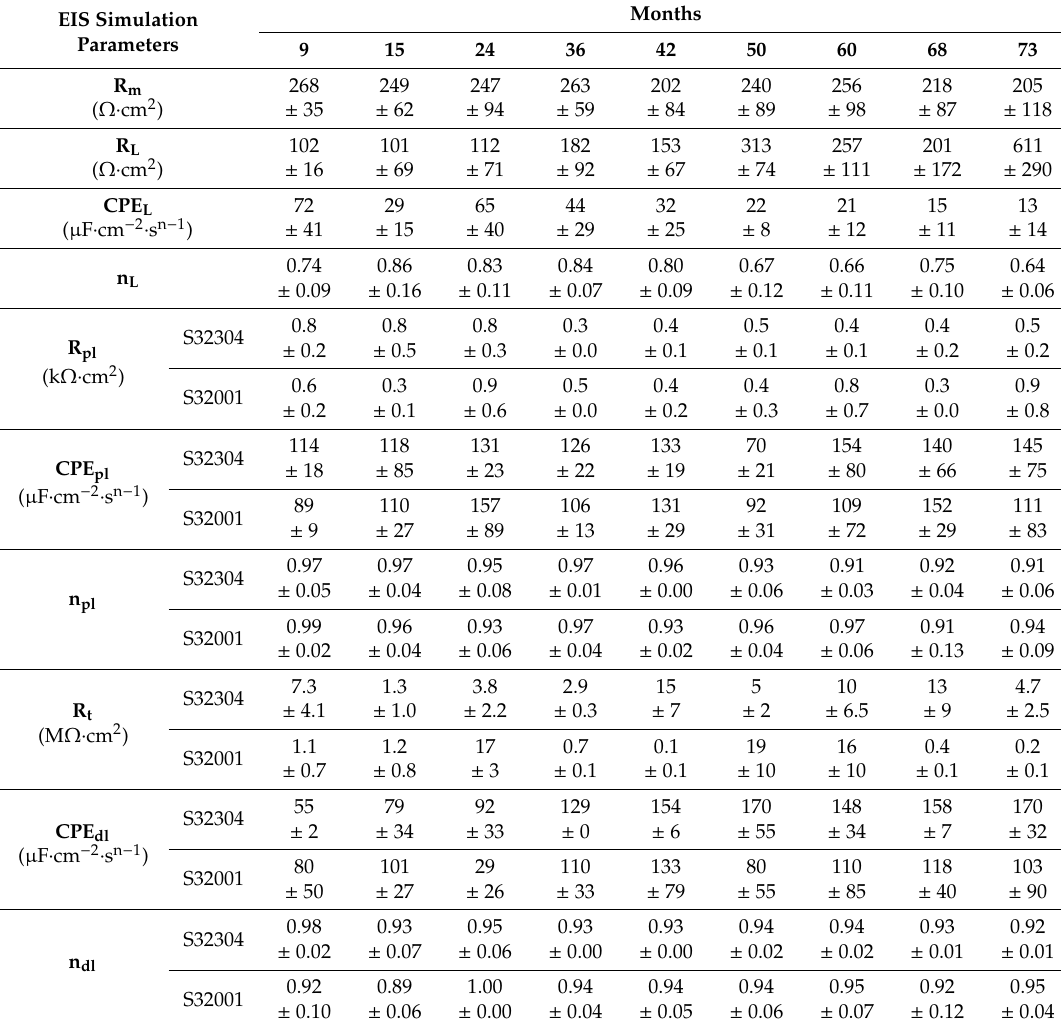
Table 4. Results from simulations of the EIS spectra of reinforced samples tested under PI-PC condition. EIS Simulation